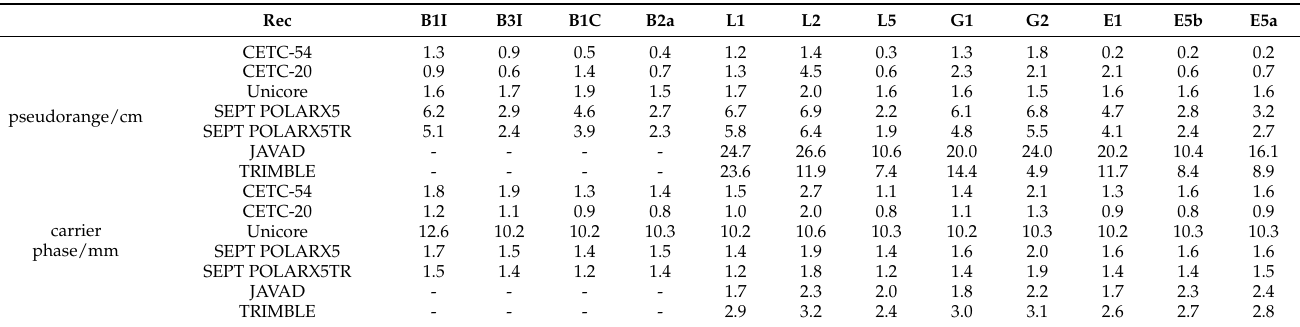
Table 5. Mean pseudorange and carrier-phase noise of receivers from 7 manufacturers analyzed by triple-differenced method.